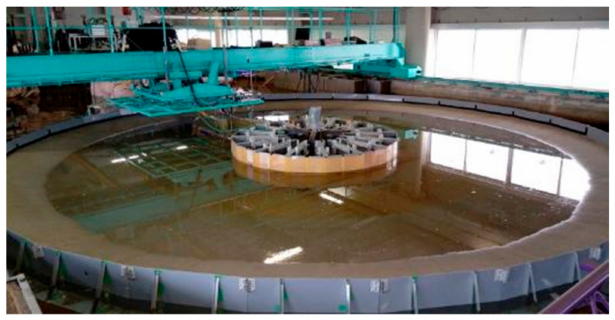
Figure 4. Circular wave-making water